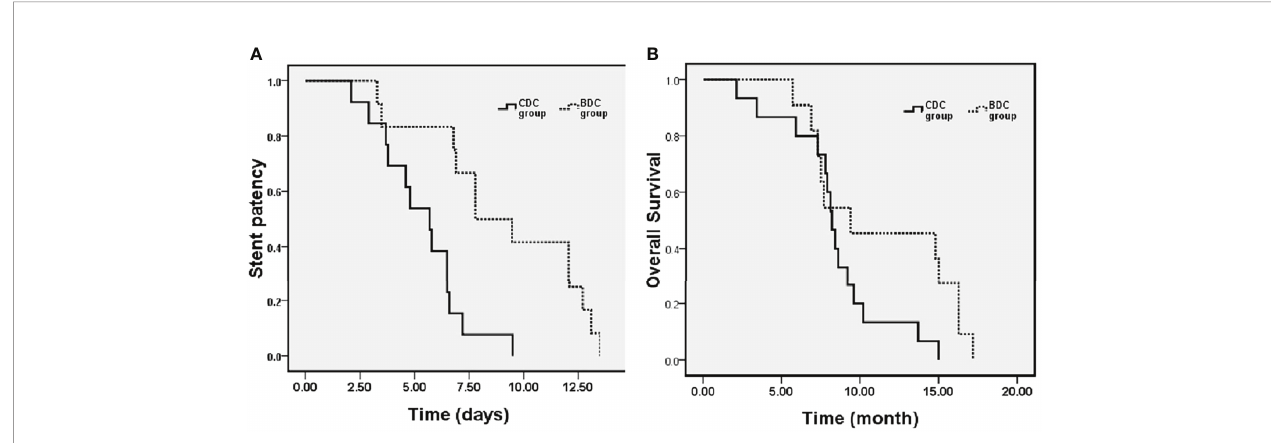
FIGURE 5 | Kaplan – Meier curves showing cumulative stent patency (A) and overall survival (B) of BDC and control